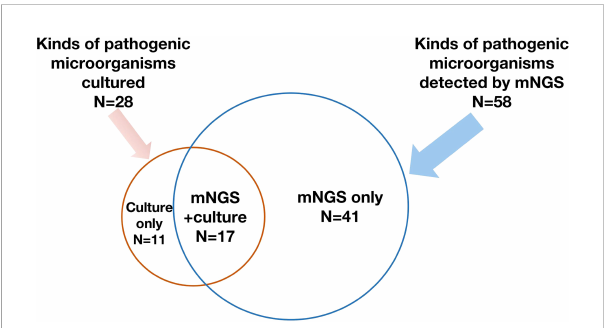
FIGURE 2 A total of 58 kinds of pathogenic microorganisms were detected by mNGS, while 28 of them were cultured from conventional culture, and 17 kinds of pathogenic microorganisms were found by both mNGS and conventional culture. mNGS, metagenomic next- generation